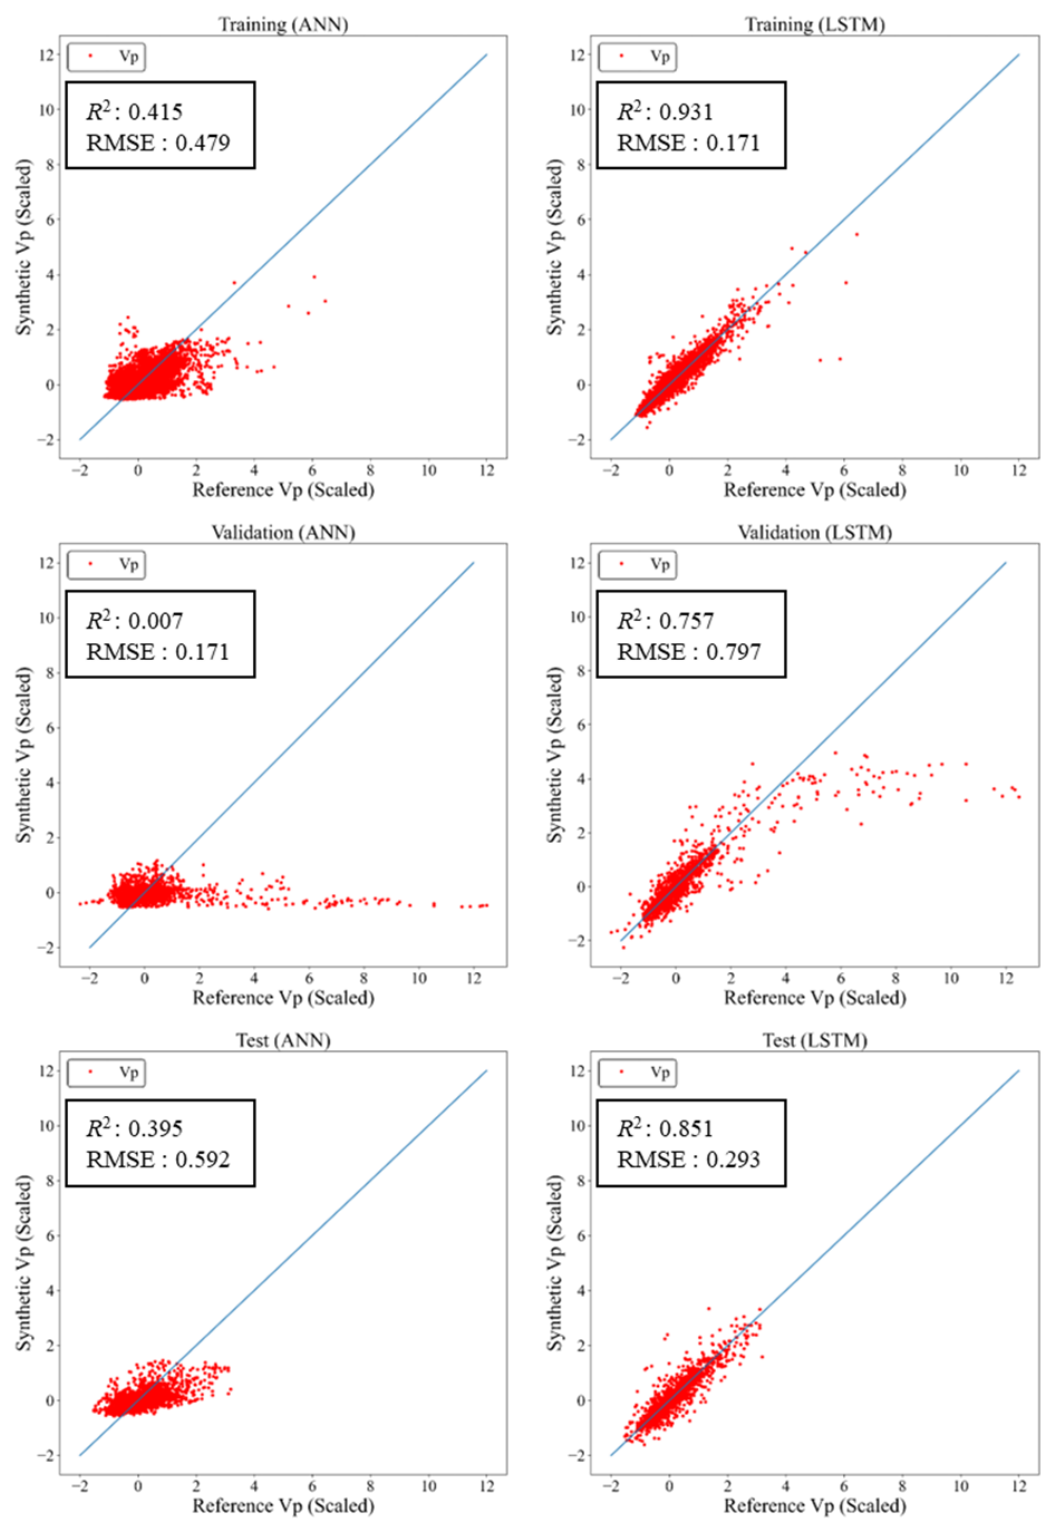
Figure 7. Scatter plots comparing the reference and predicted Vp data (scaled) for the training, validation, and test data for the ANN and LSTM (Fold 1).